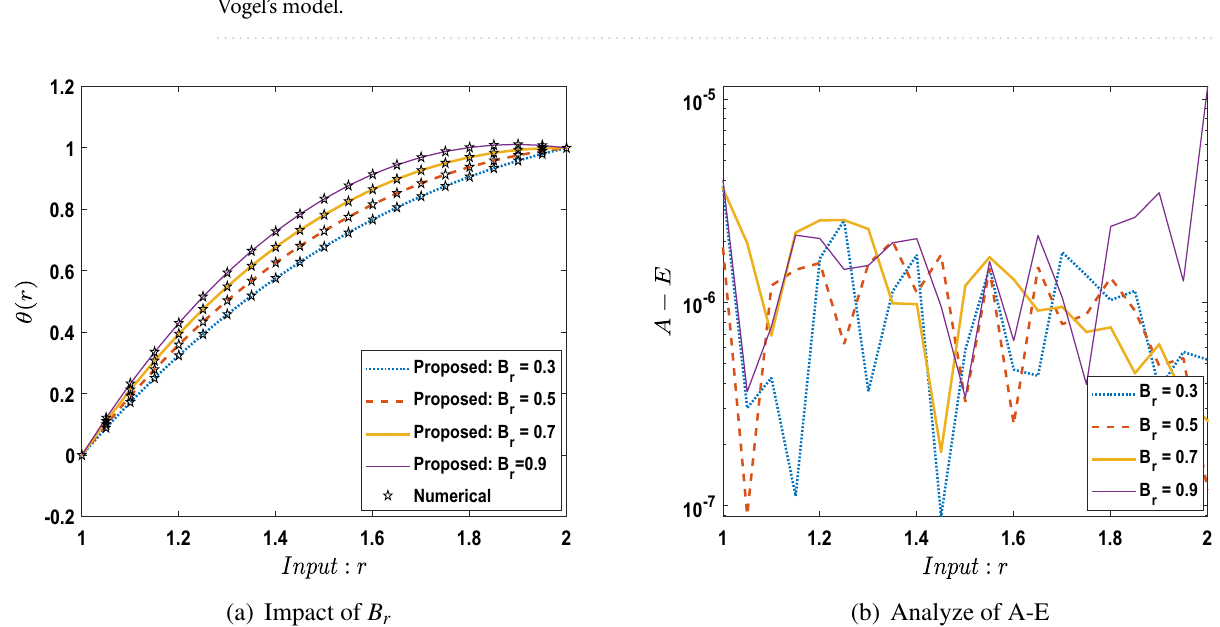
Figure 28. Comparison between suggested LMA-TNN with results of numerical reference for scenario 4 in Vogel’s model.